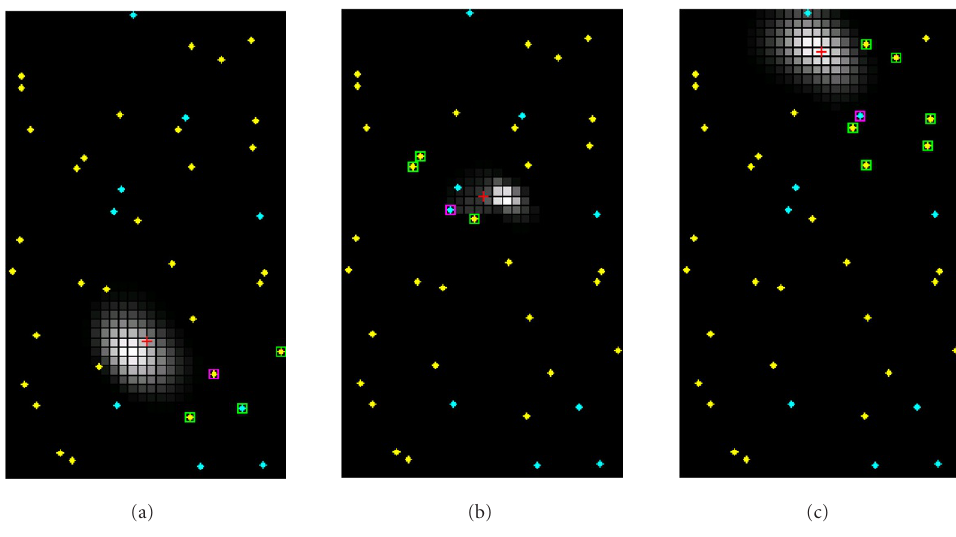
Figure 8: Snapshots of a simulation run with 40 sensors, 30% DOA. The target is marked with a red “+.” The yellow diamonds are acoustic amplitude sensors; the cyan diamonds are DOA sensors. The active leader is the sensor circled with a magenta square. Its neighbors (after applying the triplet rule) are circled with green squares.